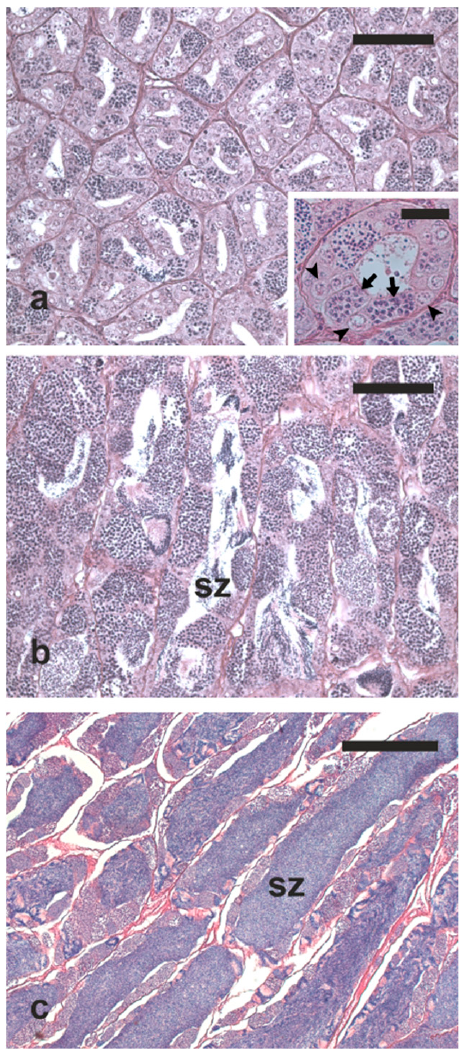
Figure 8. Micrographs of testis sections from cage-reared meagre in different reproductive conditions. ( a ) Testis in quiescent state sampled in March, whose germinal epithelium was mainly constituted by single spermatogonia and spermatogonial cysts (inset). ( b ) Testis in active spermatogenesis sampled in April, showing all stages of spermatogenesis and a limited number of luminal spermatozoa. ( c ) Mature testis sampled in June showing seminiferous tubules filled with spermatozoa. Haematoxylin ‐ eosin staining. Magnification bars = 100 μ m in ( a ) and ( b ); 30 μ m in inset of ( a ); 300 μ m in ( c ). Arrow, spermatogonial cyst; arrowhead, single spermatogonium; sz, spermatozoa.